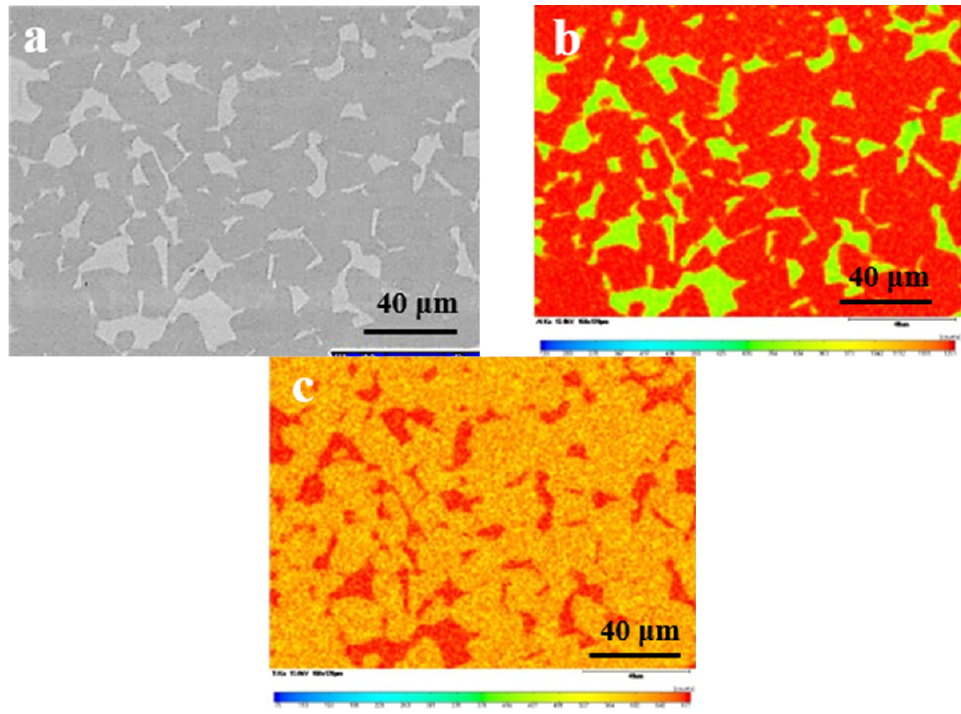
Figure 7. ( a ) SEM image, ( b ) Al, and ( c ) Ti element distribution maps of H1350 sample. The relationship between Vickers hardness and sintering temperature is shown in Figure 8. The hardness value of as-sintered compact increased with the increasing of sintering temperature, but decreased after 1400 ◦ C. The reason for the hardness increasing was that the relative density increased and the porosity decreased with the temperature increasing at 1300–1400 ◦ C. Upon a further increase in the temperature to 1450 ◦ C, the hardness value decreased due to the coarse grains and the transformed structure from duplex to sub-lamellar structure. High sintering temperature promoted unnecessary grain growth, which was harmful to mechanical properties. Therefore, 1350 ◦ C and 1400 ◦ C were selected as appropriate sintering temperatures for PM Ti-48Al alloys. Compared with as-sintered samples, the HIP samples had lower hardness, as shown in Figure 8a. Under the action of high temperature (1200 ◦ C) and high pressure (140 MPa), the grains significantly grew and the structure became